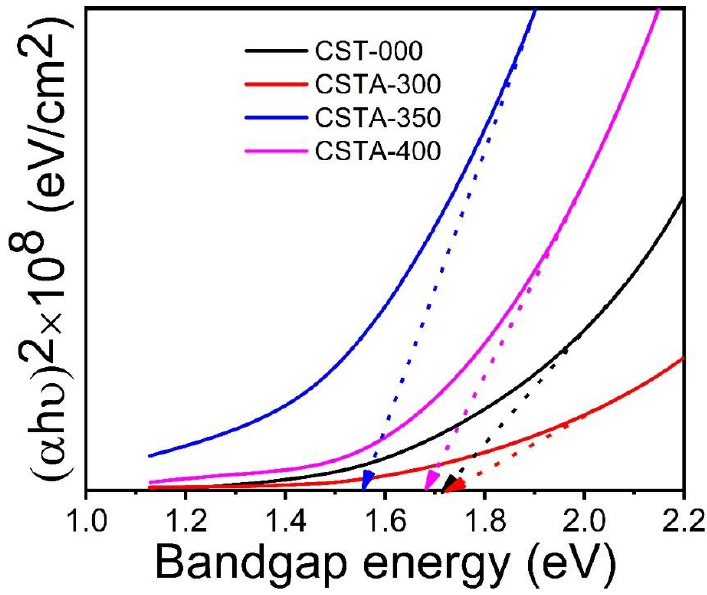
Figure 4. Band gap energy curves of the non-annealed and annealing temperatures of CdSe 0.6 Te 0.4 samples.